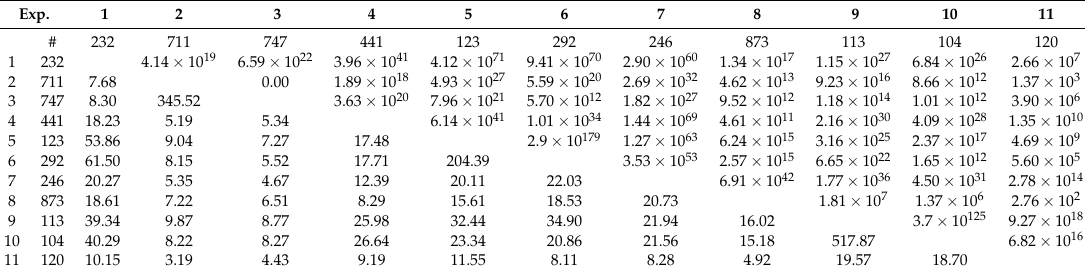
Table 2. Fisher’s exact tests for coincidence among 11 miRNA transfection experiments. Upper triangle: P -value; lower triangle: odds ratio.